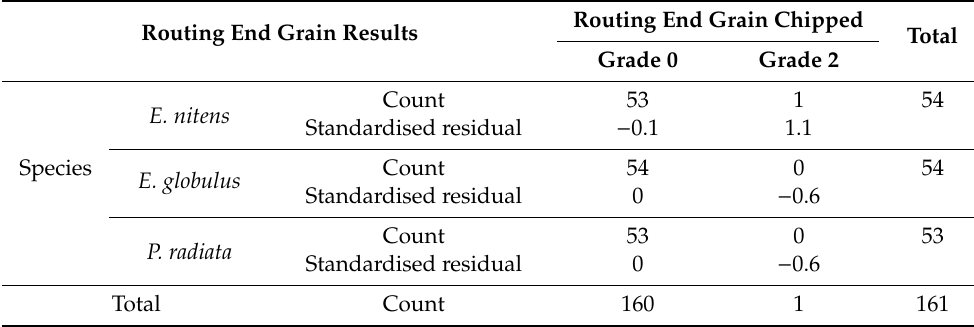
Table 3. Grading results according to routing end grain.